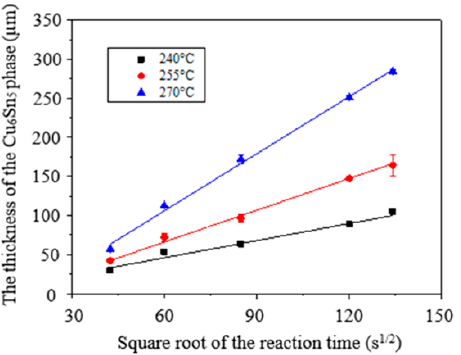
Figure 11. The thickness of the Cu 6 Sn 5 phase ( μ m) relative to the square root of reaction time (s 1/2 ) at different reaction temperatures in the SC/C1990 HP.